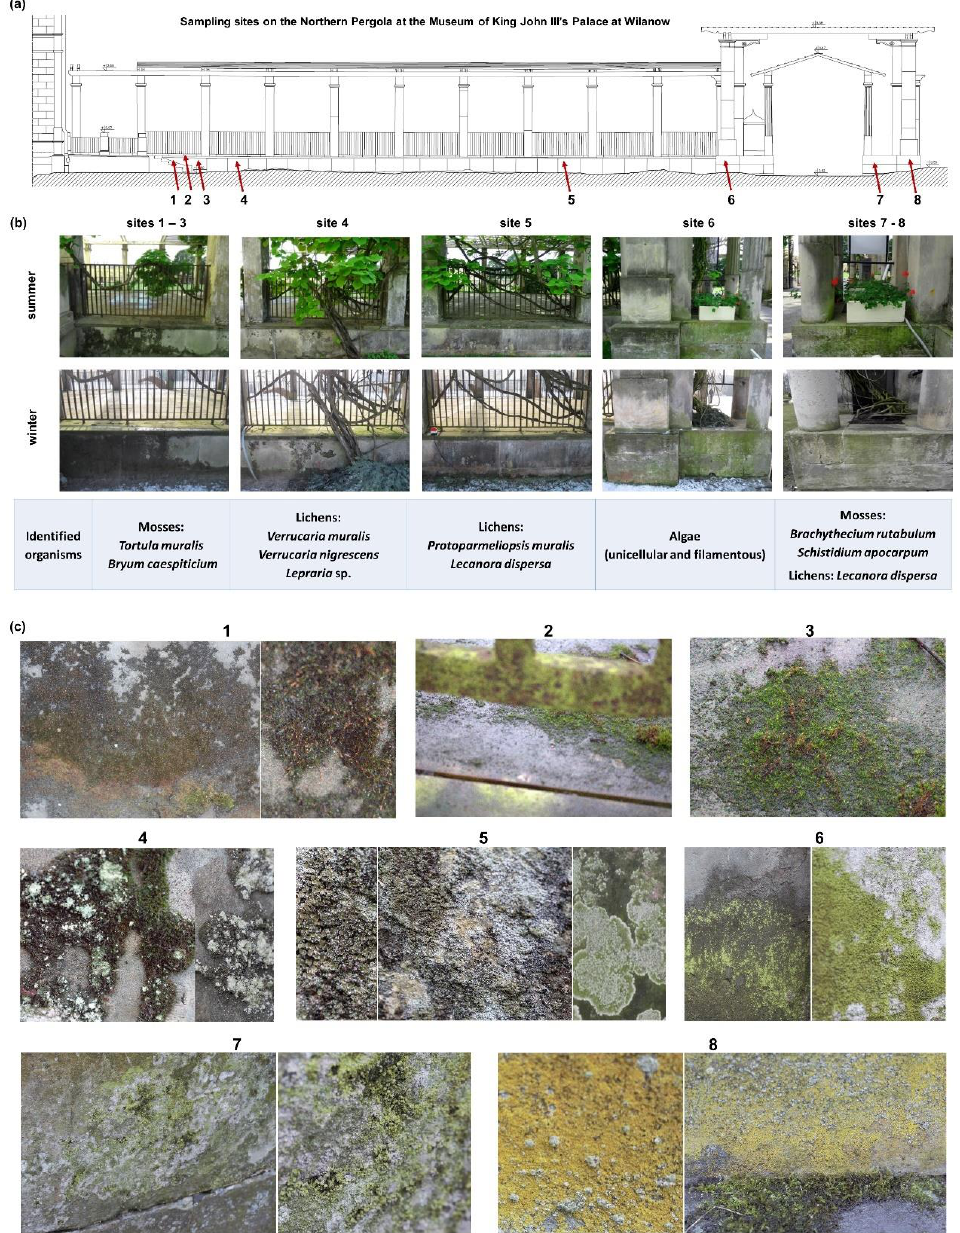
Figure 2. Architectural chart of the Northern Pergola at the Museum of King John III’s Palace at Wilanow with sampling locations ( a ), most important identified characteristic species of organisms inhabiting sandstone surfaces ( b ) and biodeterioration patterns of the sandstone surfaces ( c ).